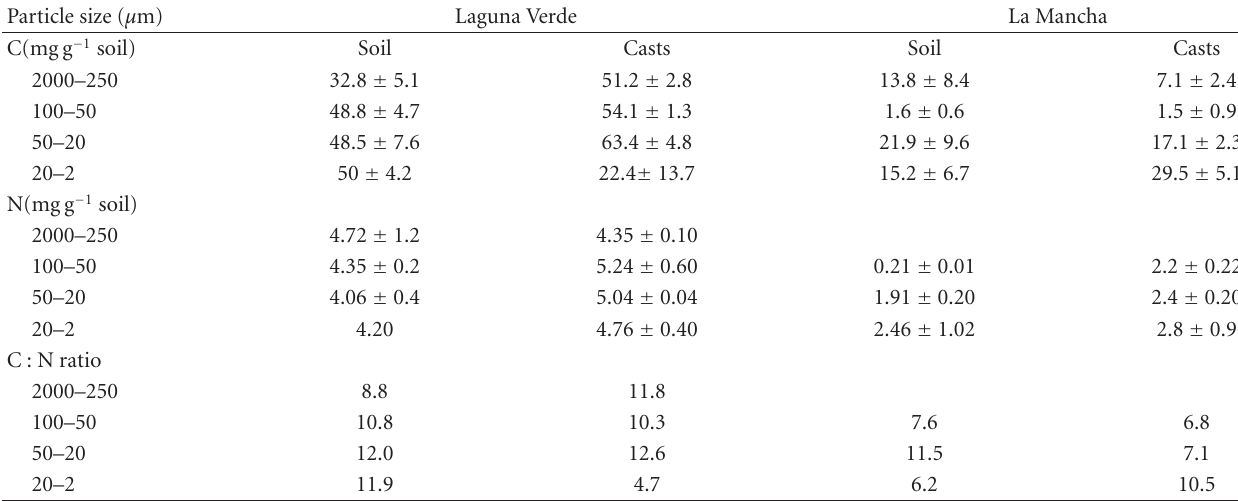
Table 5: C and N contents and C : N ratio in particle-size organic fractions in control soil and cast of Pontoscolex corethrurus ( ± SE) [53].